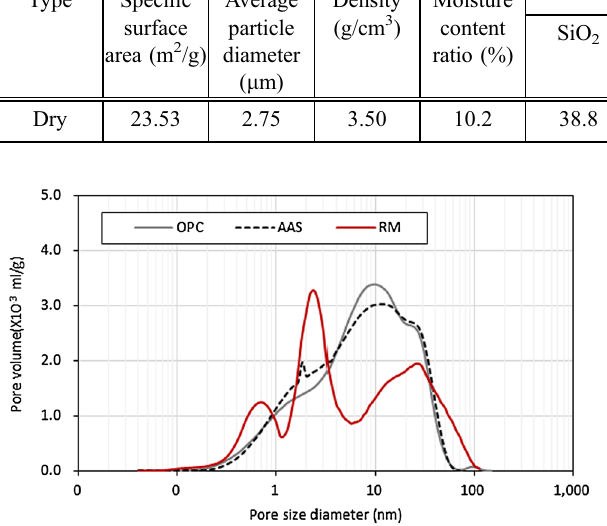
Fig. 3 Particle size distribution of fine